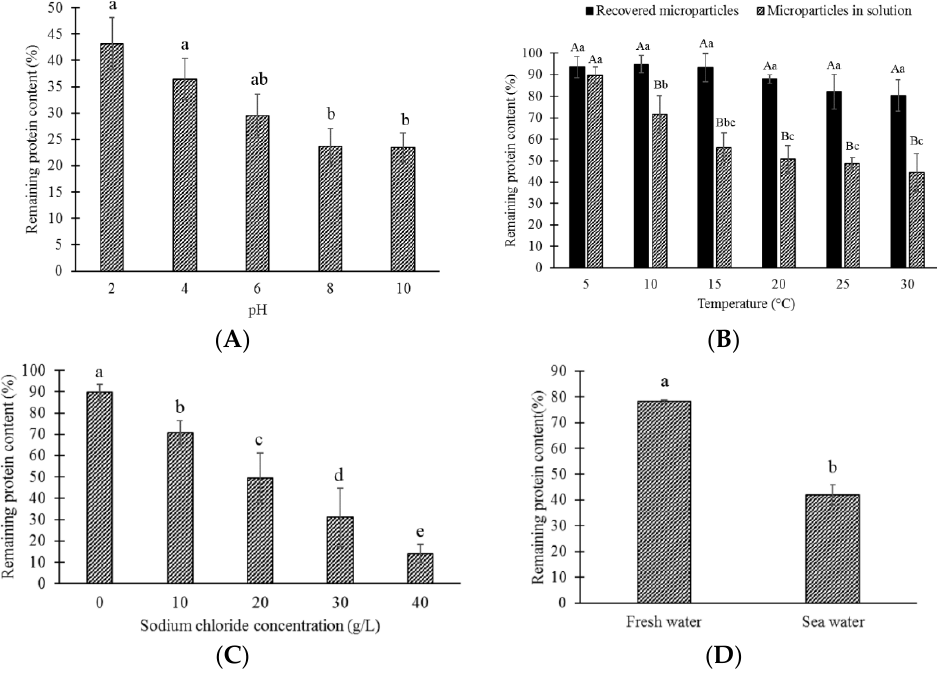
Figure 4. The effect of different environmental conditions on microparticle stability and protein release. ( A ) Effect of pH; ( B ) Effect of temperature; ( C ) Effect of salinity; ( D ) Effect of type of water. Different lowercase letters indicate significant differences ( p ≤ 0.05) of the remaining protein content (%) among the different points of evaluation within the same type of sample. Different capital letters in Figure 4B indicate significant differences ( p ≤ 0.05) of the remaining protein content among the different types of samples (recovered microparticles, microparticles in solution) within the same